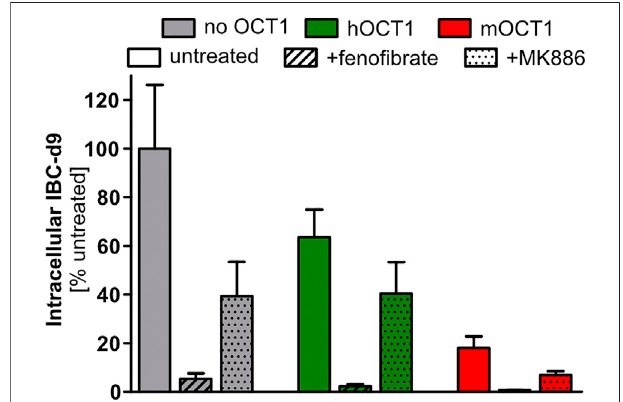
FIGURE 7 | Isobutyrylcarnitine depletion inducible by PPAR α activation. Pretreatment for 24 h with 33 µM feno fi brate, an activator of PPAR α , led to strong reduction of intracellular IBC. But somehow unexpectedly, the PPAR α inhibitor MK886 also reduced intracellular IBC. Data are represented as the mean ± SEM from four independent experiments. This data illustrates that the OCT1 effect on IBC concentrations may also be due to more complex signaling interactions and not due to an OCT1 mediated membrane transport of